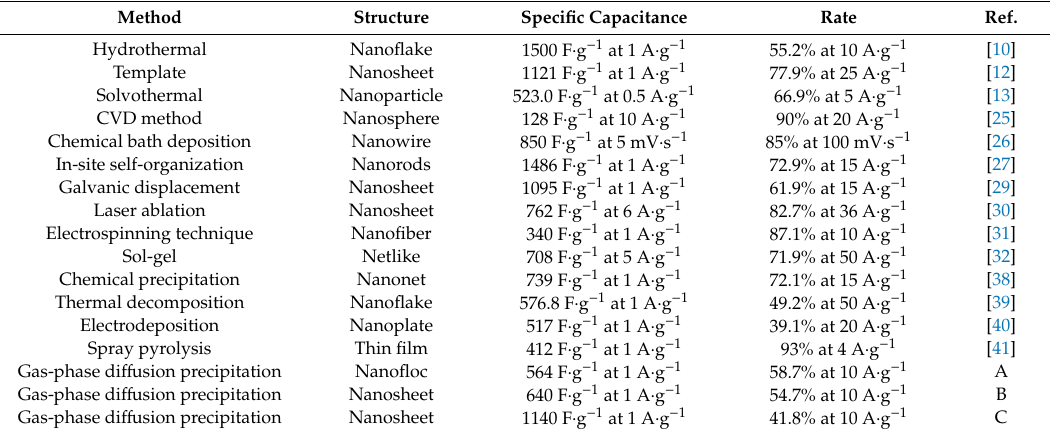
Table 2. Electrochemical performance of Co 3 O 4 electrode materials.